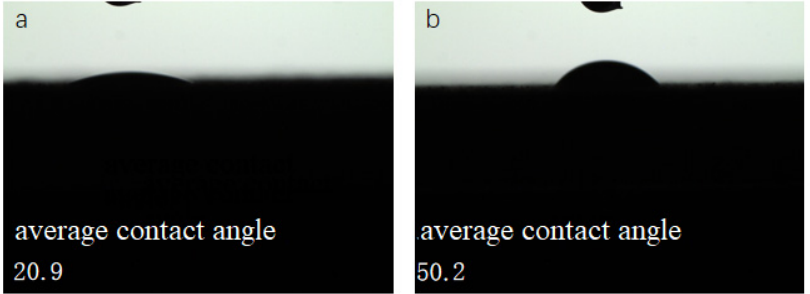
Figure 5. Contact angle test before and after treatment with the silane coupling agent: ( a , b ) are the contact angle test results before and after treatment of the same sample with an initial contact angle of 20.9°.